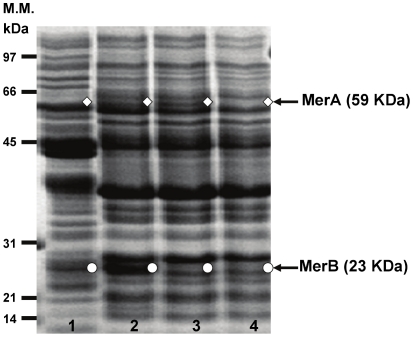
Synthesis of MerB and MerA proteins in C. metallidurans strain MSR33.Proteins of cells grown in LPTMS medium in presence (lanes 1–3) and absence of Hg2+ (lane 4) were separated by SDS-PAGE and stained with Coomassie blue. Lanes: 1, E. coli JM109 (pTP6) grown in presence of Hg2+; 2, C. metallidurans strain MSR33 grown in presence of Hg2+; 3, C. metallidurans strain CH34 grown in presence of Hg2+; 4, C. metallidurans strain CH34 grown in absence of mercury. White diamonds and circles indicate MerA and MerB proteins, respectively. Molecular mass of protein standards in kD are shown on the left side of gel.